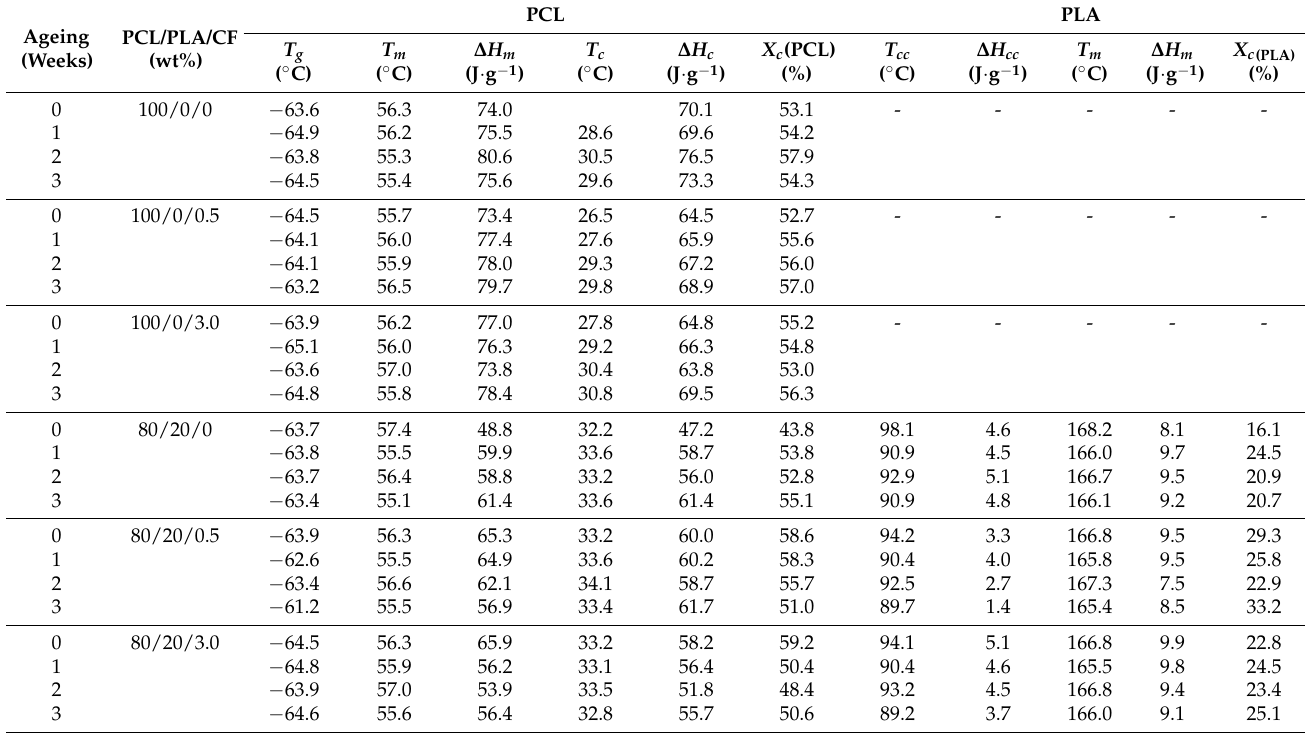
Table 6. DSC data for the cooling and second heating cycle of PCL/PCL/CF blends exposed to radiation in an environmental chamber for up to 3